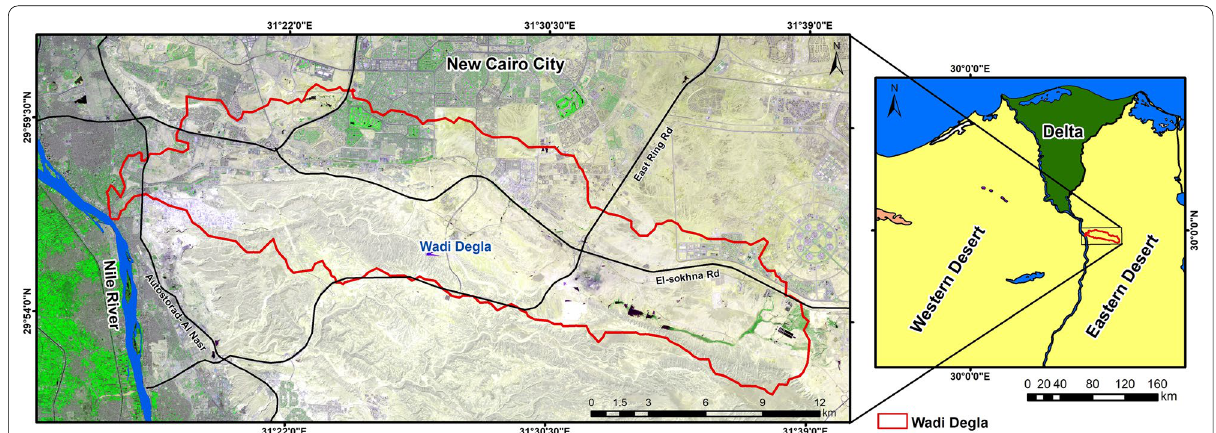
Fig. 1 Location of the study area and the urban features located within its premises on Landsat satellite image (October